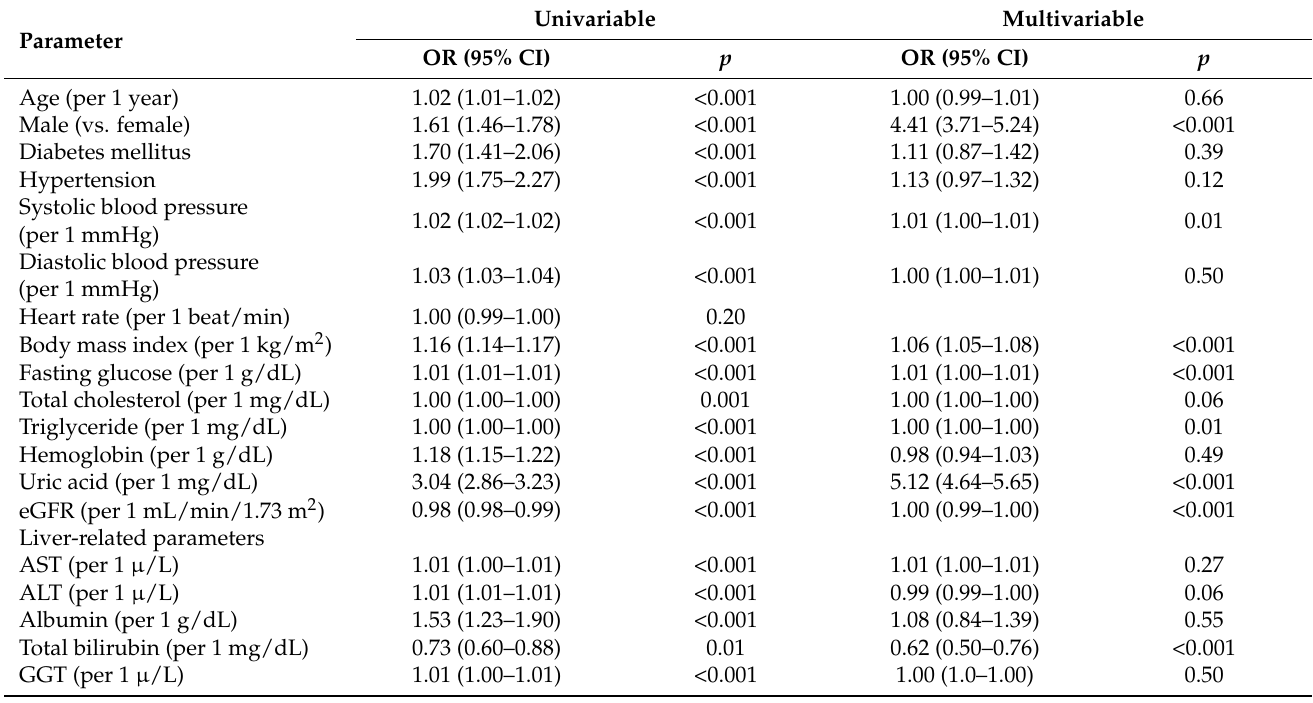
Table 2. Determinants of new-onset hyperuricemia using binary logistic analysis in all 21,030 study participants.